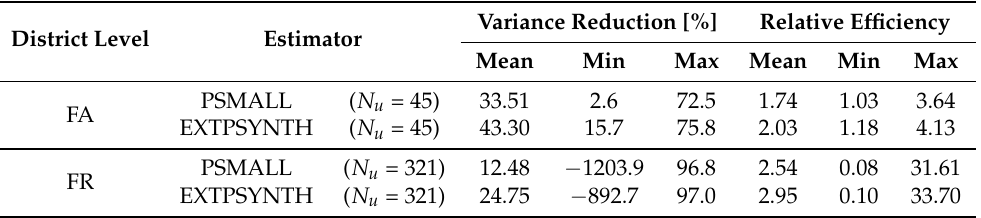
Figure 5. Cumulative distribution of variance reduction by the PSMALL and EXTPSYNTH compared to the SRS estimator for the 45 FA and 321 FR units. Table 7. Descriptive summary of variance reduction compared to SRS and relative efficiencies on the two forest district levels. N u : number of evaluated small area